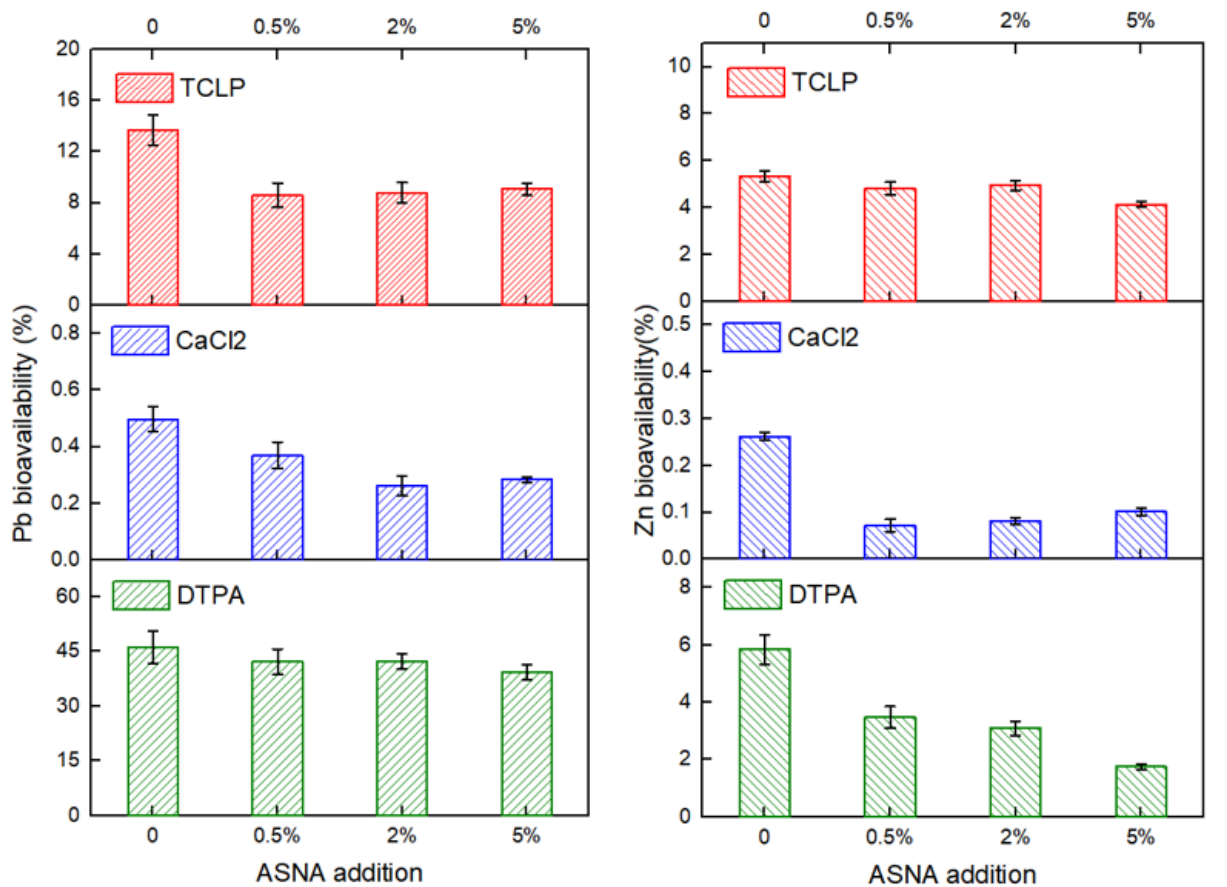
Figure 4. The effect of ASNA on the bioavailability of Pb and Zn in soil.